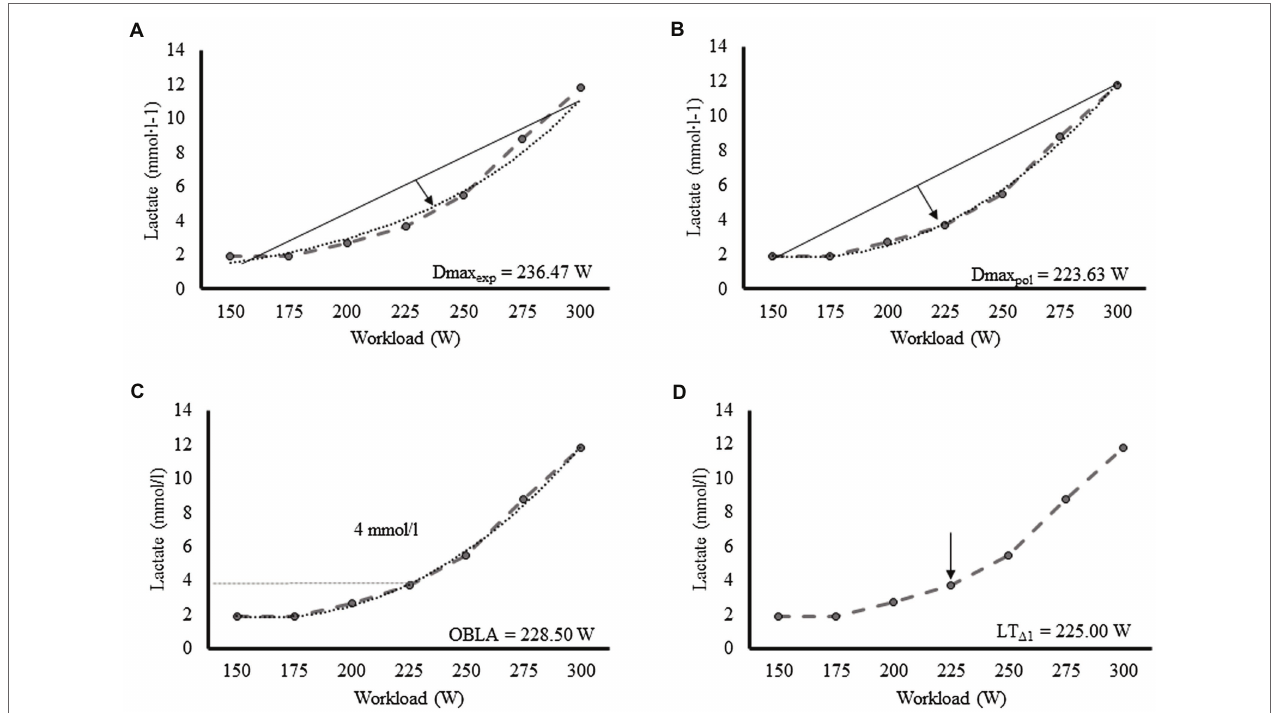
FIGURE 1 | Representative lactate curve of a participant showing the determination of Dmax exp (A) , Dmax pol (B) , OBLA (C) , and LT lactate